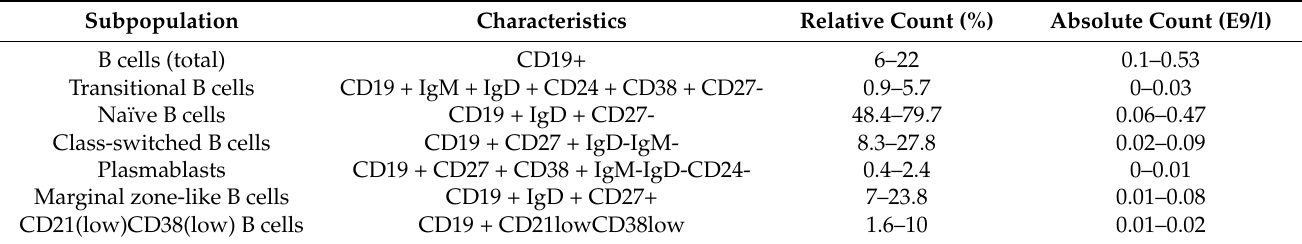
Table 2. Characteristics, relative (% of CD19+ cells), and absolute counts of B-cell subpopulations in peripheral blood [50].